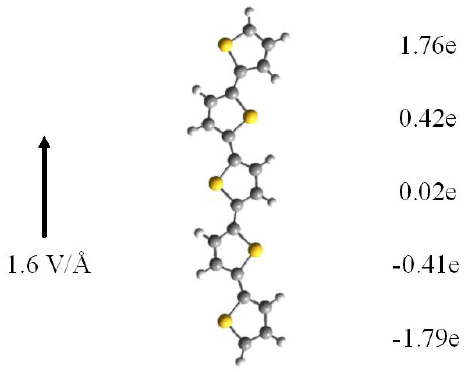
Figure 3. Field-induced charge transfer in isolated polythiophene; charges per ring obtained by a Mullikan